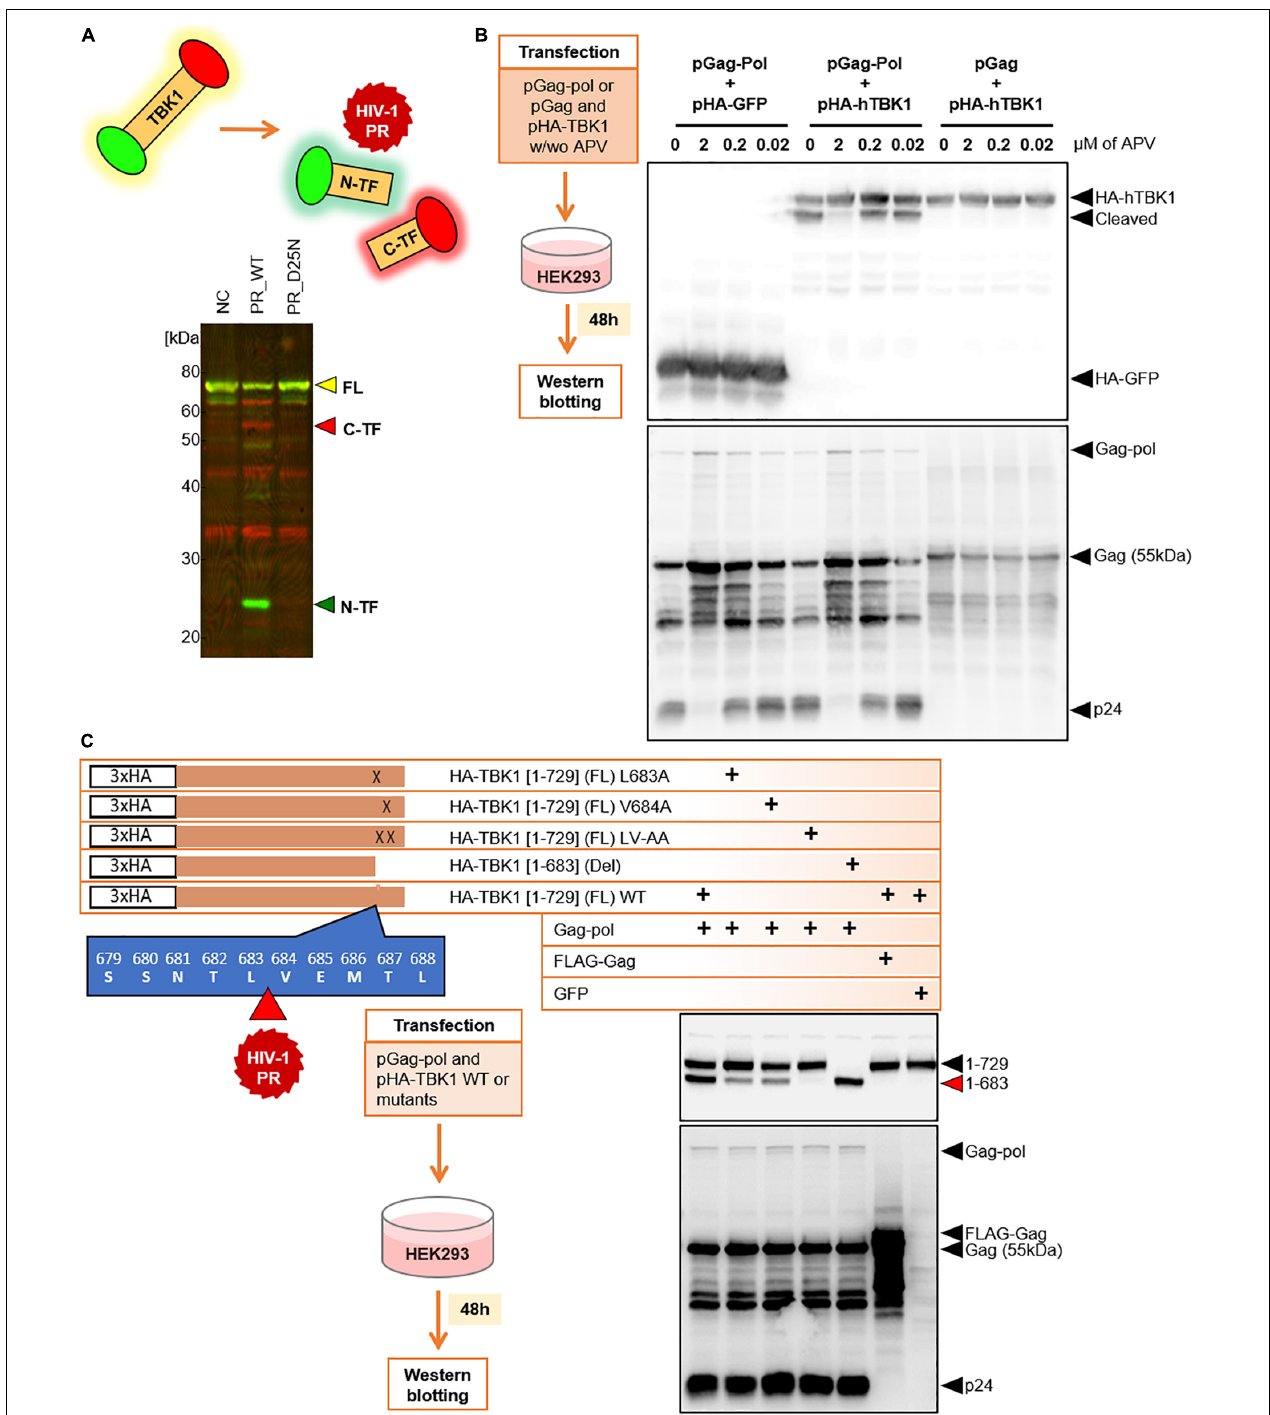
FIGURE 2 | HIV-1 protease cleaves TBK-1. (A) Recombinant TBK1 protein with N-terminal green and C-terminal red fluorescence. Full length protein fluoresces yellow when intact. Upon in vitro proteolytic cleavage with HIV-1 PR, the N-terminal fragment fluoresces green while the C-terminal fragment fluoresces red detected by distinct bands in western blot. NC Negative control represents recombinant full length fluorescent TBK1 without addition of HIV-1 PR, FL Full length, C-TF C-terminal fragment, N-TF N-terminal fragment. (B) Western blot analysis 48 h after transfection of HEK293 cells with Gag-Pol or Gag with HA tagged TBK1 in the presence or absence of serial concentrations of amprenavir. Cleaved and non-cleaved TBK1 bands on the immunoblot were observed with anti-HA antibody. APV amprenavir. (C) Full length wild type TBK1, three cleavage site specific substitution mutants and one deletion mutant were generated with HA tag. Western blot analysis done 48 h after transfection of HEK293 cells with either of these TBK1 and pGag-Pol. TBK1 cleavage bands were observed with anti-HA antibody and p55 cleavage bands were visualized with anti-p24 antibody.